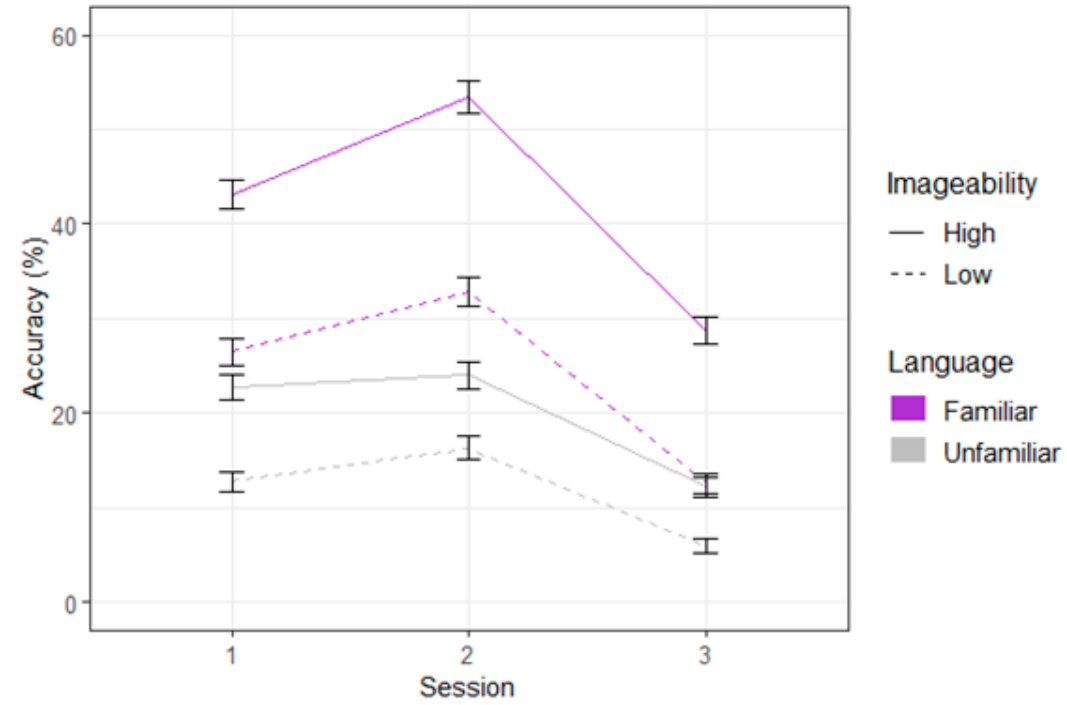
ff ects of familiarity and imageability on accuracy (%) in sessions 1, 2, and Figure 1. Effects of familiarity and imageability on accuracy (%) in sessions 1, 2, and 3. Figure 1. E